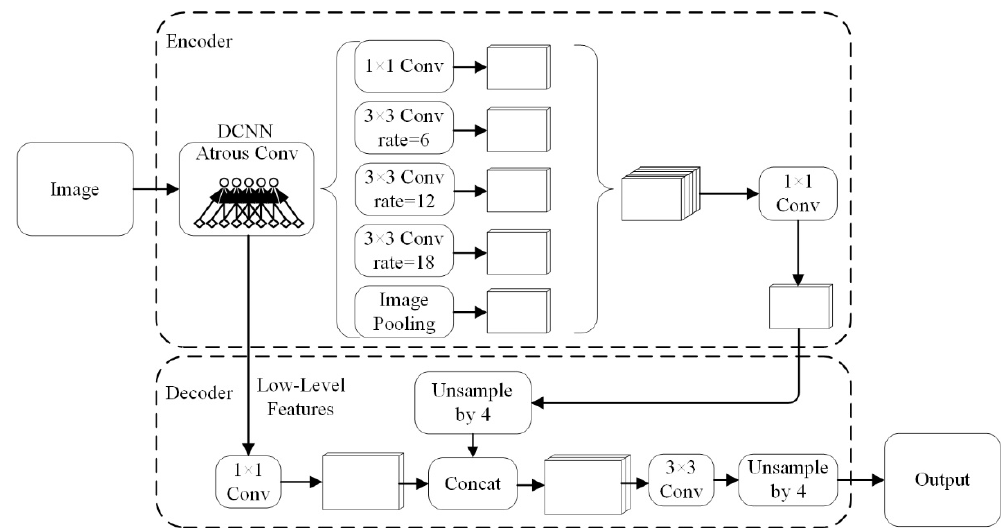
Figure 3. DeepLabV3+ network block structure.